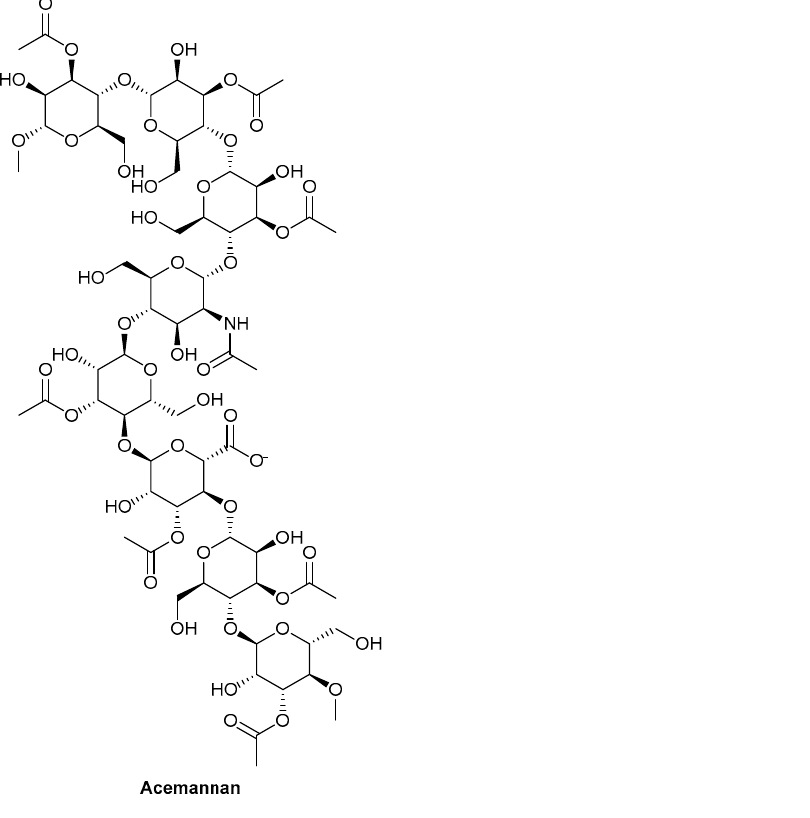
Figure 11. Chemical structure of acemannan, one of the key polysaccharides of Aloe vera (L.)